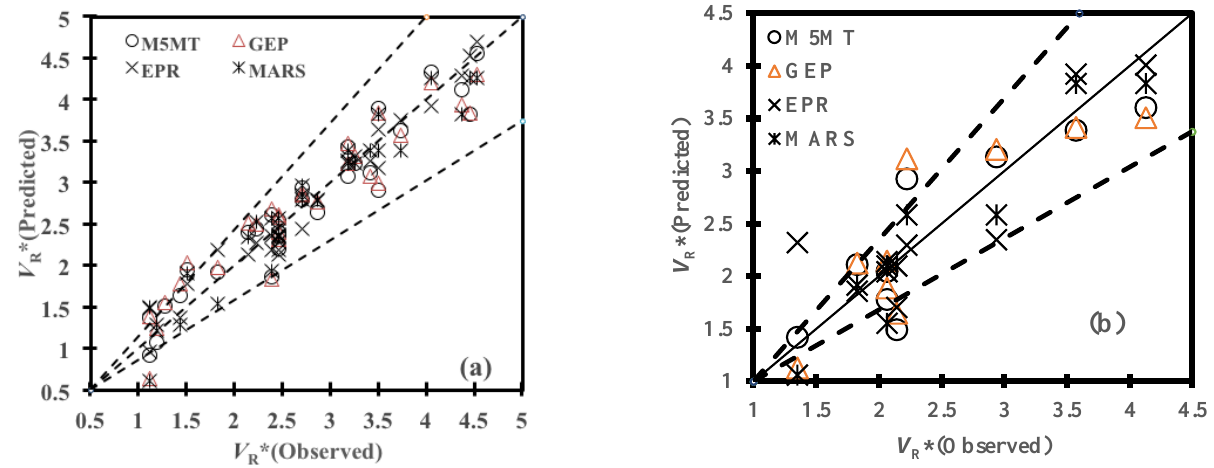
Figure 7. Performance of AI models in the prediction of V ∗